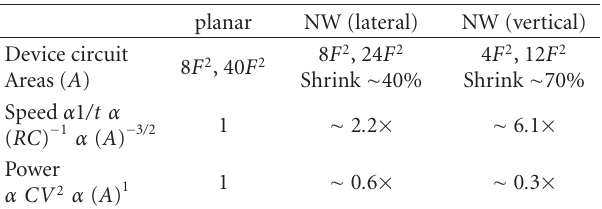
Table 1: Benchmarking of lateral and vertical nanowire devices with